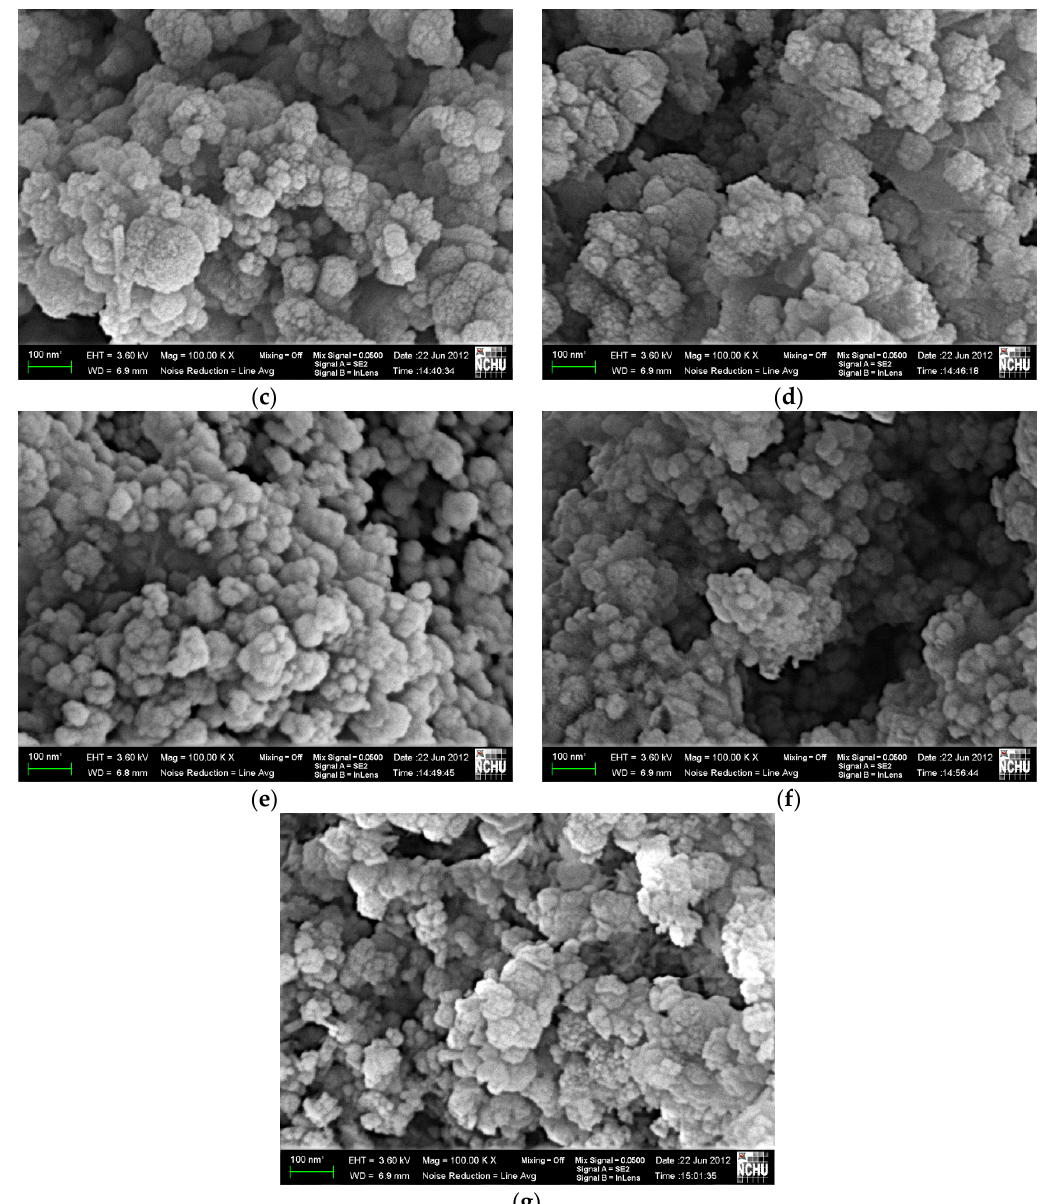
Figure 6. The surface morphology of [Mn 0.54 Zn 0.46 ]Fe 2 O 4 that is produced from waste dry batteries with different pH values: ( a ) pH = 6, ( b ) pH = 7, ( c ) pH = 8, ( d ) pH = 9, ( e ) pH = 10, ( f ) pH = 11 and ( g ) pH = 12. Table 2. The effect of pH on the mean diameter.